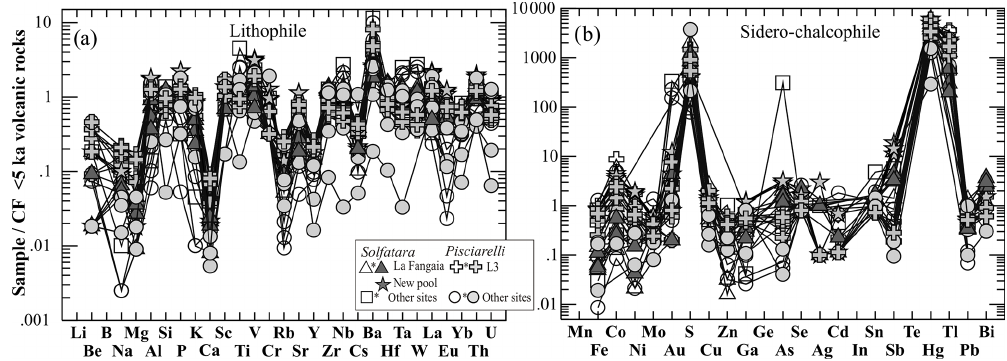
Figure 8. Lithophile (a) and sidero-chalcophile (b) element concentrations normalized with respect to the average whole-rock composition of pristine volcanic rocks with an age < 5ka (D’Antonio et al., 1999; Piochi et al., 2014), as those outcropping in the Puteoli sulfate areas. The asterisk ( ∗ ) in the legend indicates other datasets (not